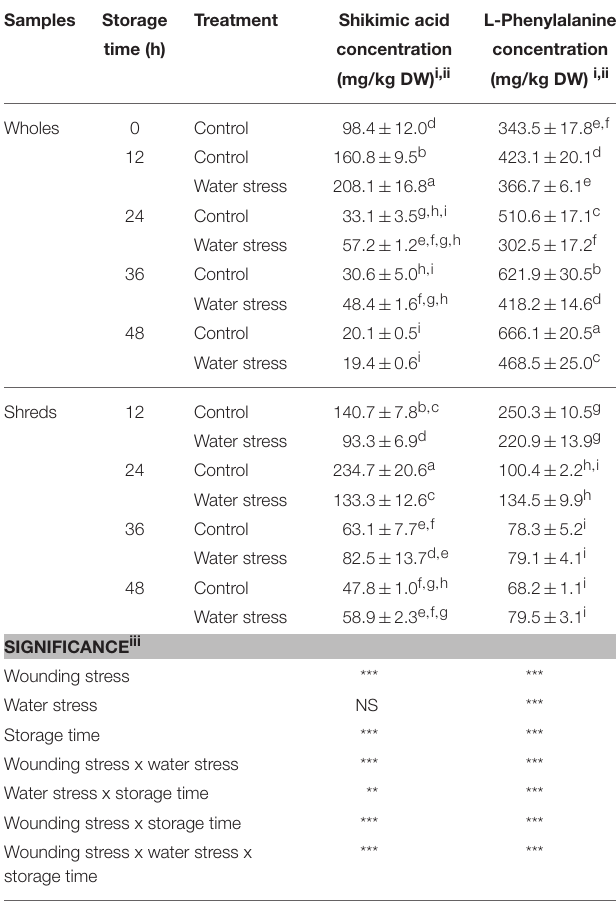
TABLE 2 | Effects of wounding and water stress on the concentration of shikimic acid and phenylalanine during storage of carrots.